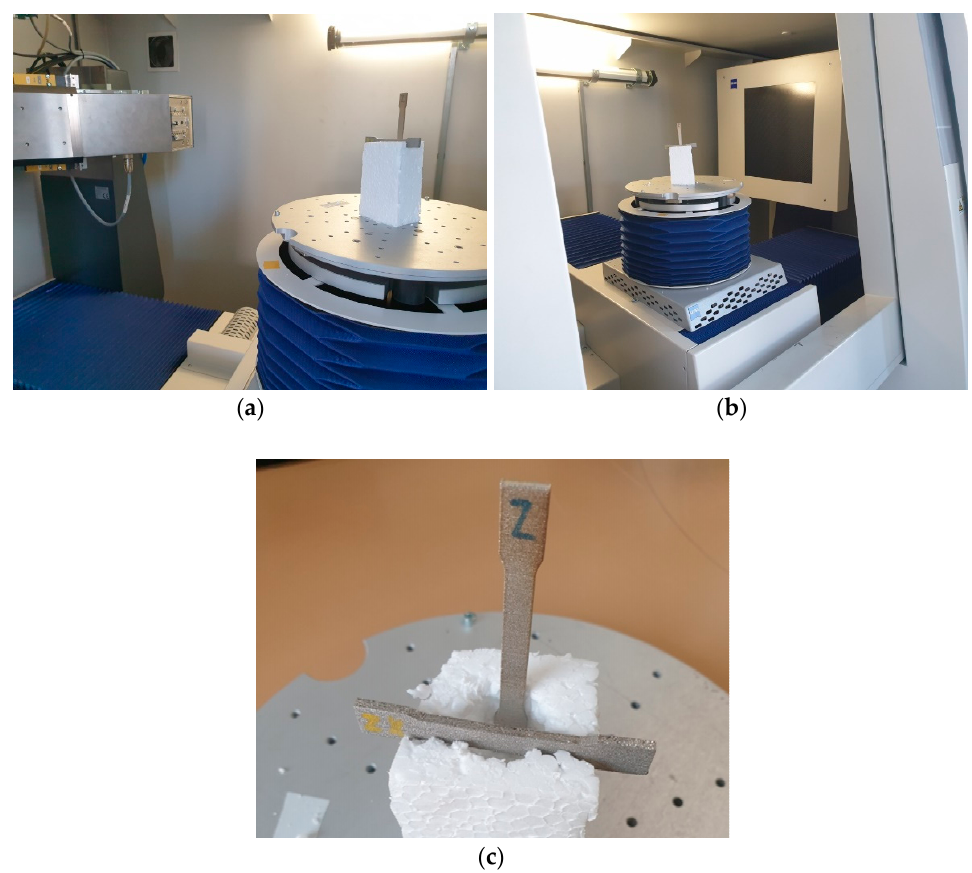
Figure 4. The position of the parts in the computer tomography device ( a ) View of the source of the X-rays, ( b ) View of the X-ray detector, ( c ) View of the experimental parts.